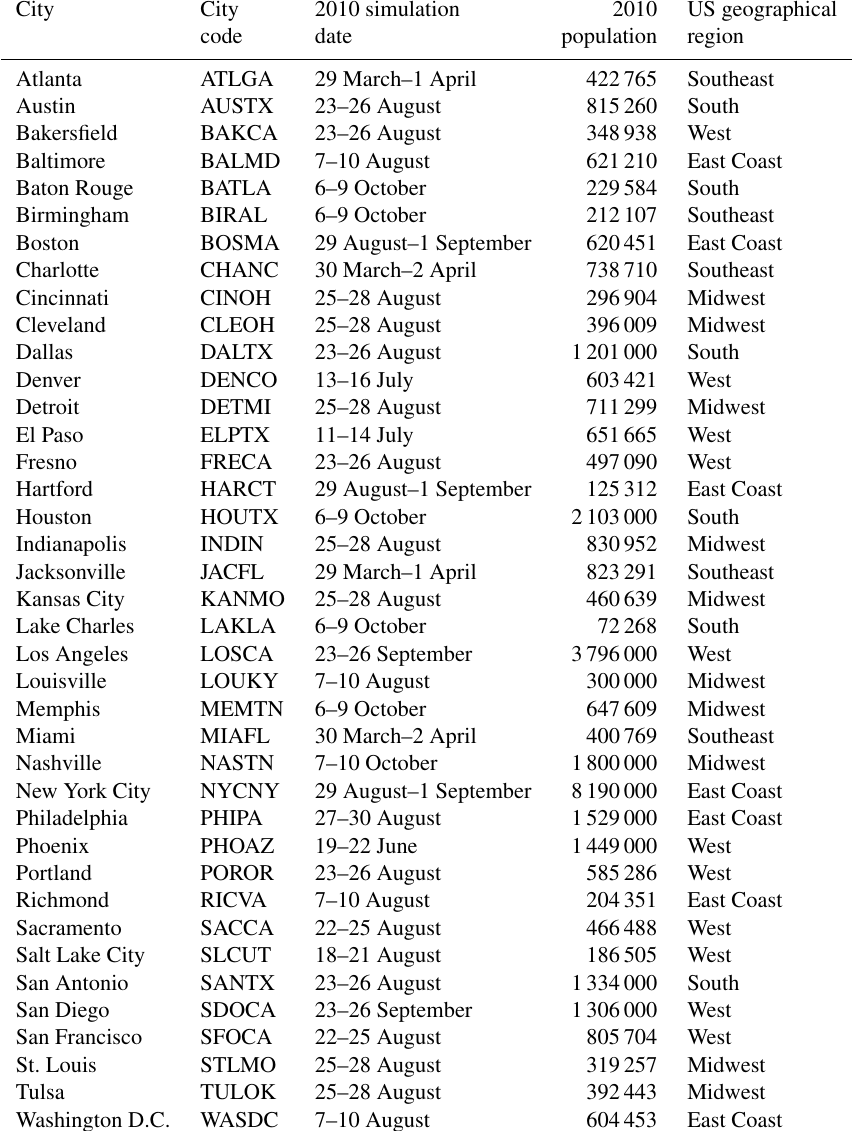
Table 1. City, city code, simulation date, 2010 population, and geographical region.